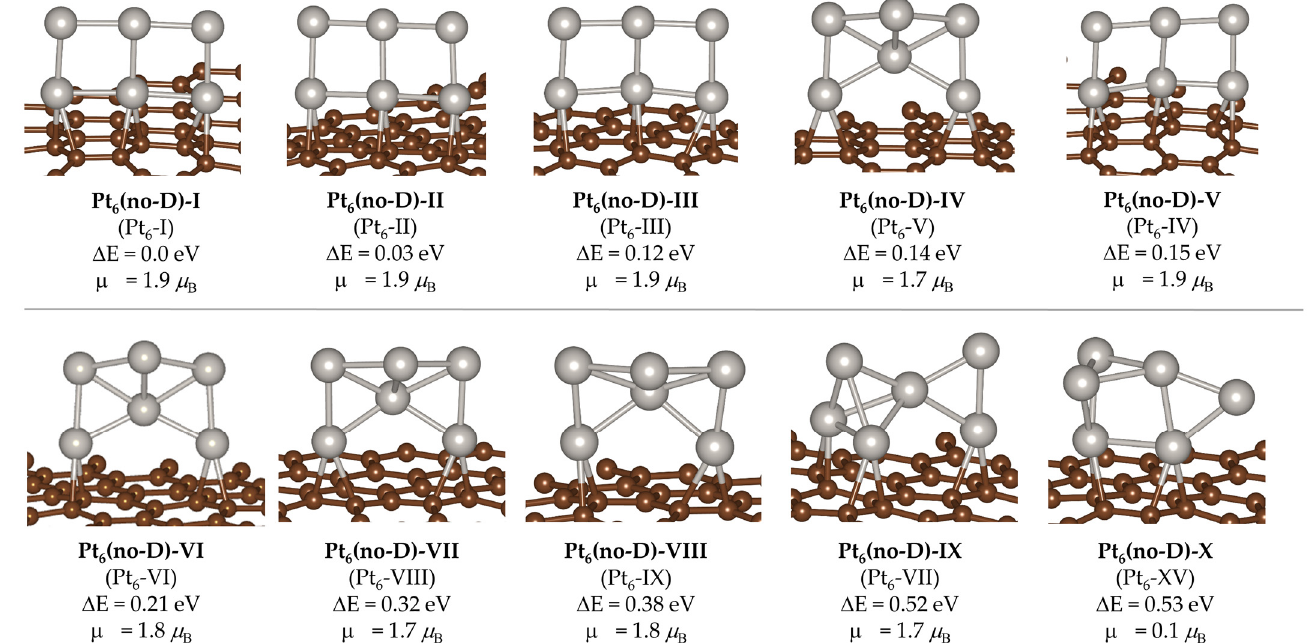
Figure 4. Frontal view for the ten lowest ‐ in ‐ energy local minimum for Pt 6 /graphene optimized without dispersion corrections. Δ E corresponds to the energy difference with respect to the GM; the total magnetic moment of the system (per unit cell) is provided in Bohr magnetons.